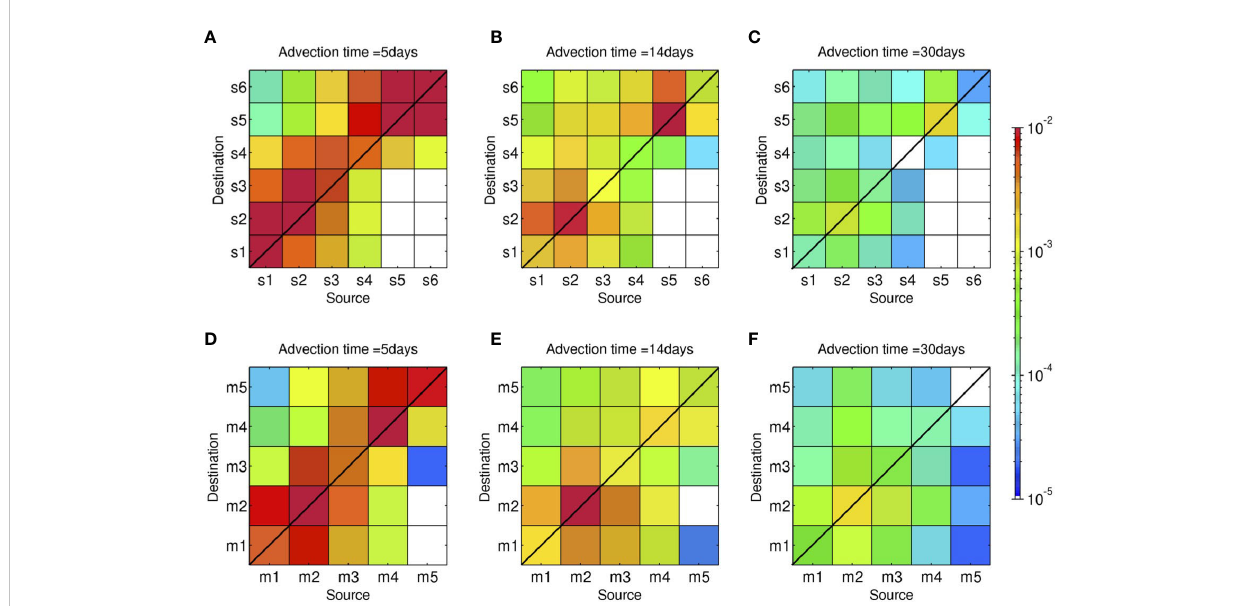
FIGURE 3 Horizontal connectivity matrices around the northwest coast of Okinawa Island for the advection times T a of 5, 14, and 30 days. Colors indicate the probability, viz., connectivity C ij . The x -axes show the grouped source areas, and the y-axes show the grouped sink areas shown in Figure 2. Upper panels (A – C) : shallow connectivity matrices for releases at a depth of 2 m (Case 1). Lower panels (D – F) : mesophotic connectivity matrices for releases from a depth of 30 m (Case